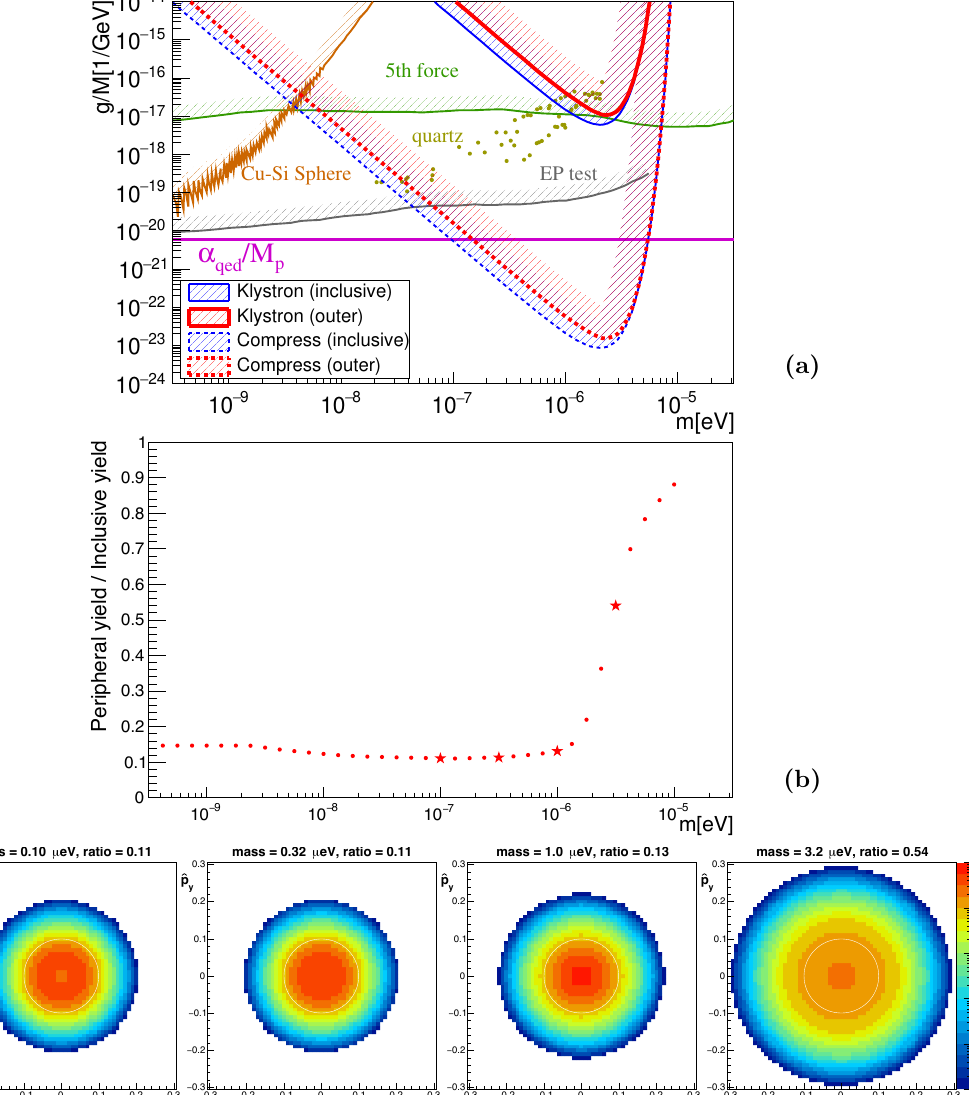
Figure 3 . Sensitivity curves and the ratio of outer emissions with the parameters listed in table 1. (a) Reachable coupling g=M vs. pNGB mass m domains. The domains above the solid curves show the reachable range with peak power and relative linewidth of GHz-photon pulses equivalent to an existing 100 MW klystron [10] (see the left column of table 1 for the linewidth and pulse duration parameters). The dotted curves show the extended sensitivities when a relatively broader linewidth (the right column for the same parameters in table 1) is used; it is assumed a system capable of this will be developed in the near future. The thicker curves show the sensitivities when the signal photons are sampled only outside the divergence angles of the incident two beams. Excluded domains (5th force and EP test) and projected sensitivities (quartz and Cu-Si Sphere) by the di(cid:11)erent methods are also superimposed by quoting limits from (cid:12)gure 1 in [4], where the details of individual curves and the relevant references can be found. (b) The ratio of the signal photon yield emitted outside the divergence angles of incident beams to that of the inclusive yield as a function of mass. The lower four panels show the numerically calculated signal yields sampled at four mass points indicated with the star markers in the ratio plot as a function of the x and y components of unit momenta of signal photons, (^ p x ; ^ p y ), at the beam waist z = 0; the white circles indicate the domains of beam divergence with the radius of sin (cid:2) 0 from eq. (A.58) in appendix. The color contours in the log scale are normalized to the common total number of signal photons.